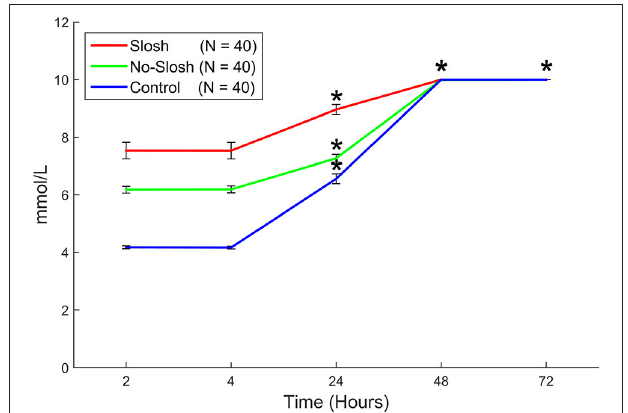
FIGURE 7 | Blood levels of K + (potassium) in “slosh,” “no-slosh,” and “control” groups, measured at 2, 4, 24, 48, and 72h post-blast. ‘*’ indicates statistically significant differences at the current time point relative to previous